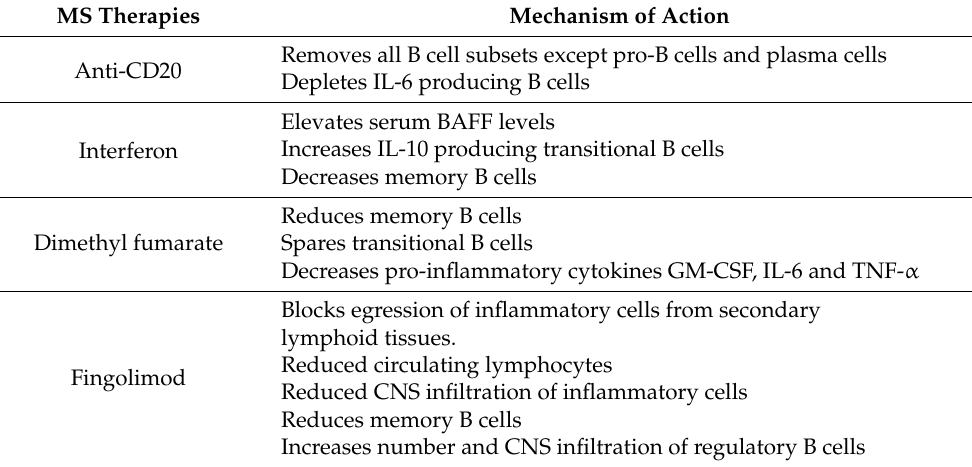
Table 2. Effects of MS therapies on B